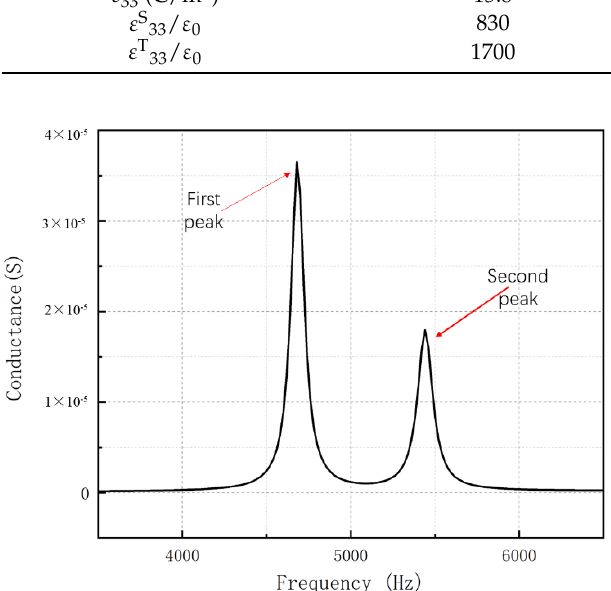
Figure 3. Conductance curve of the double − harmonic piezoelectric composite lamination ( l 1 = 50 mm, l 2 = 46.5 mm).